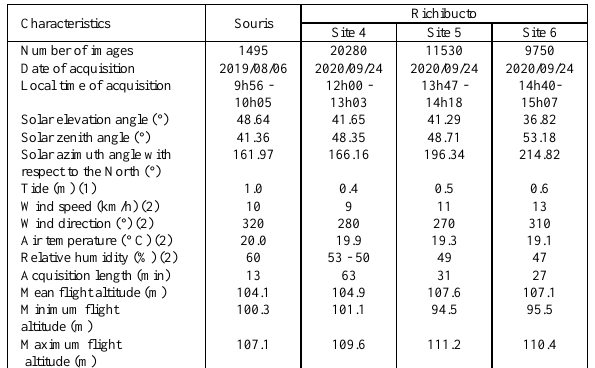
Characteristics of the UAV images and related environmental conditions during image